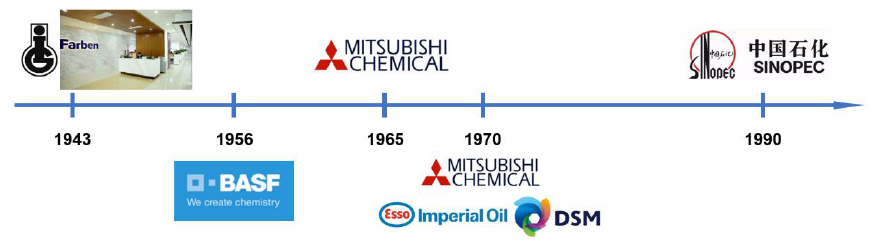
Figure 2. Overview of the development and evolution of CPL.